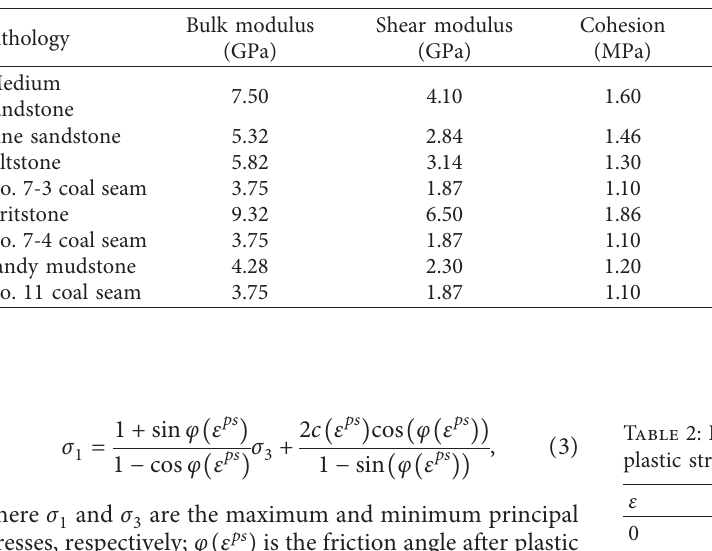
Table 1: Mechanical parameters of rock strata and coal seams.